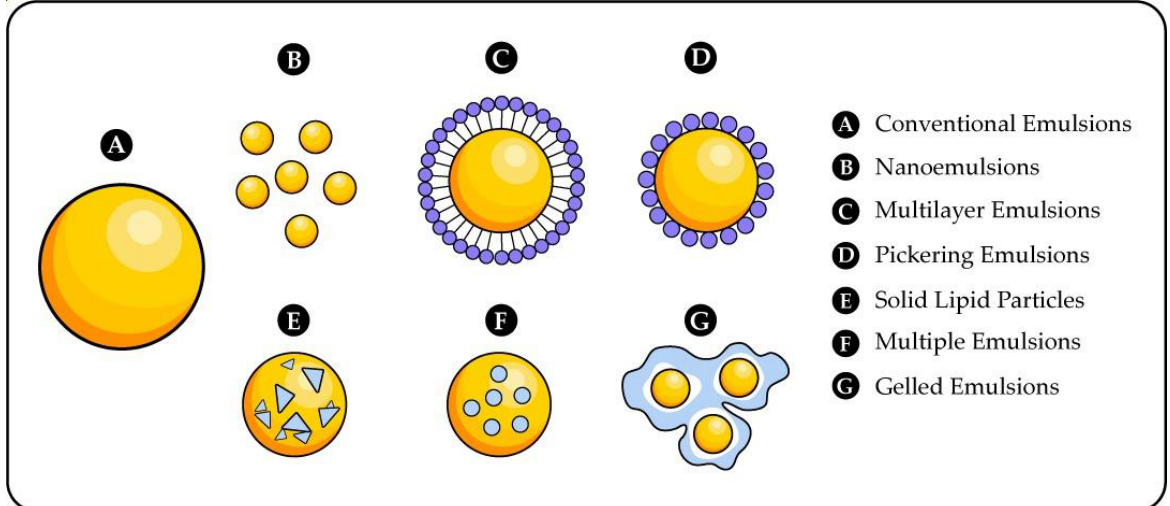
Figure 2. Schematic illustration of the emulsions.